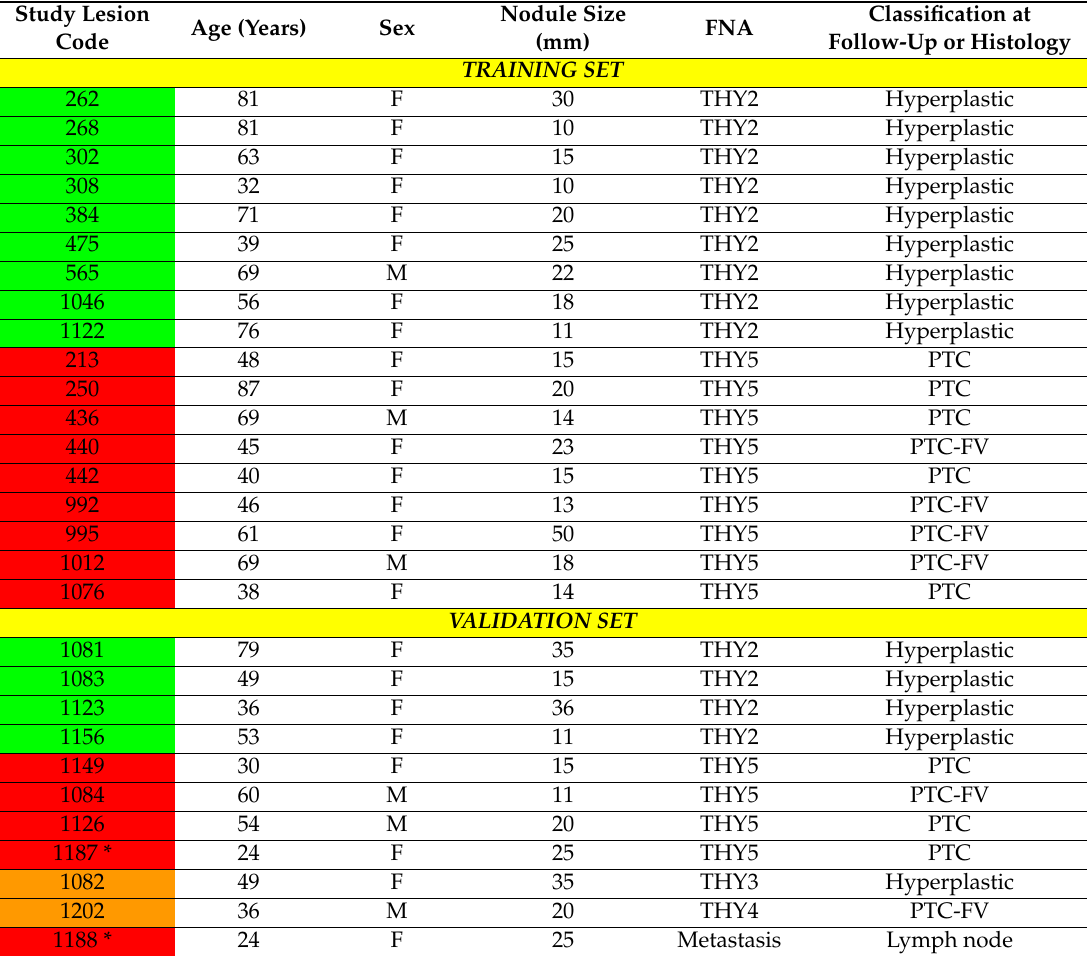
Table 1. Clinical information of the lesions and the patients included in the study. Green corresponds to Thy2 hyperplastic nodules; orange corresponds to nodules with an indeterminate for malignancy or suspicious cytological diagnosis; in red, malignant Thy5 cases are